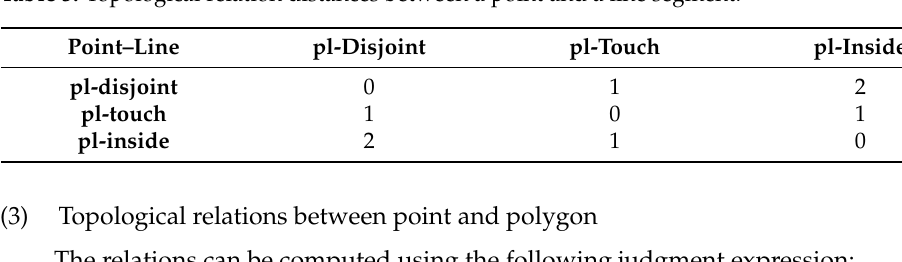
Figure 6. Conceptual neighborhood diagram of topological relations between a point and a line segment. Table 3. Topological relation distances between a point and a line